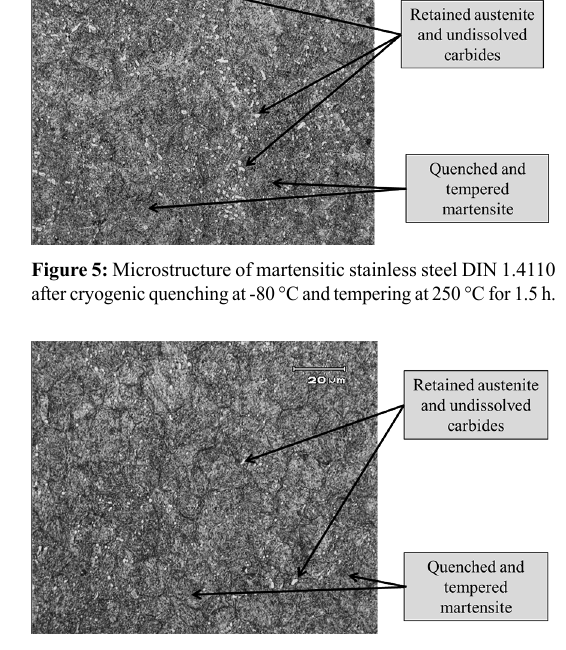
Figure 6: Microstructure of martensitic stainless steel DIN 1.4110 after cryogenic quenching at -196 °C and tempering at 250 °C for 1.5 h.